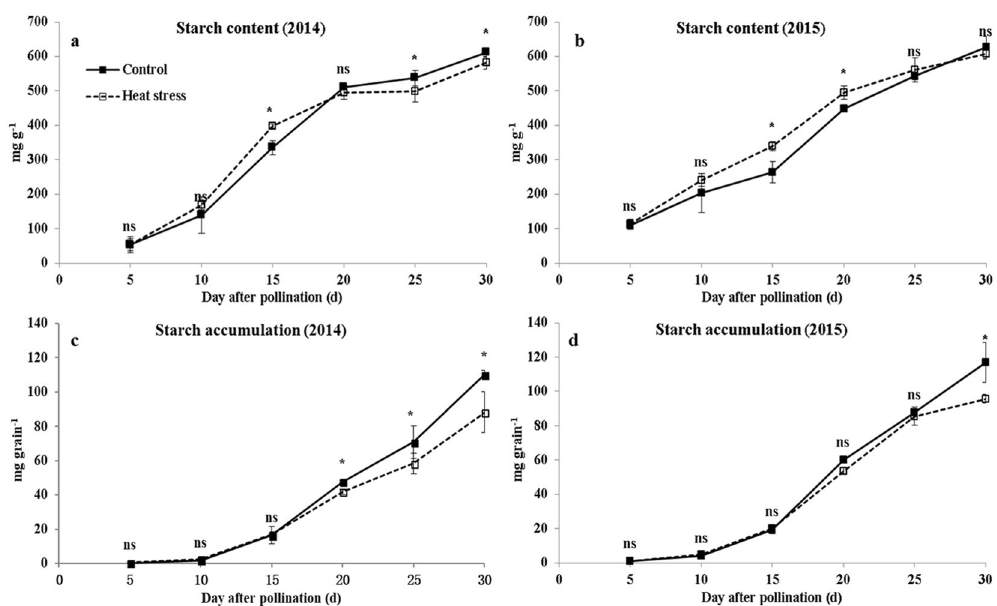
Figure 3. Grain starch accumulation during grain filling under ambient and high-temperature conditions. ( a , c and b , d ) are the grain starch content and starch accumulation in 2014 and 2015, respectively. Bars denote standard errors from three replicates, and one-way ANOVA was used to test for significance at p < 0.05